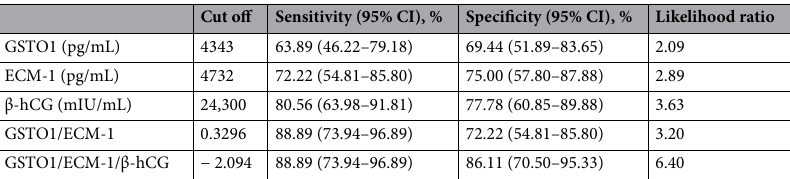
Table 2. Diagnostic value of GSTO1, ECM-1 and β-hCG for EP. GSTO1 glutathione S transferase omega 1, ECM-1 extracellular matrix protein-1, hCG human chorionic gonadotropin, EP ectopic pregnancy, CI confidence